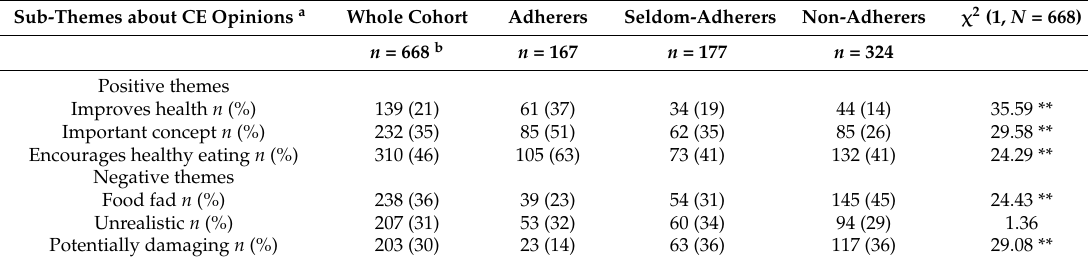
Table 3. Sub-themes regarding both positive and negative opinions towards clean eating (CE) for the entire cohort, split by adherers, seldom-adherers and